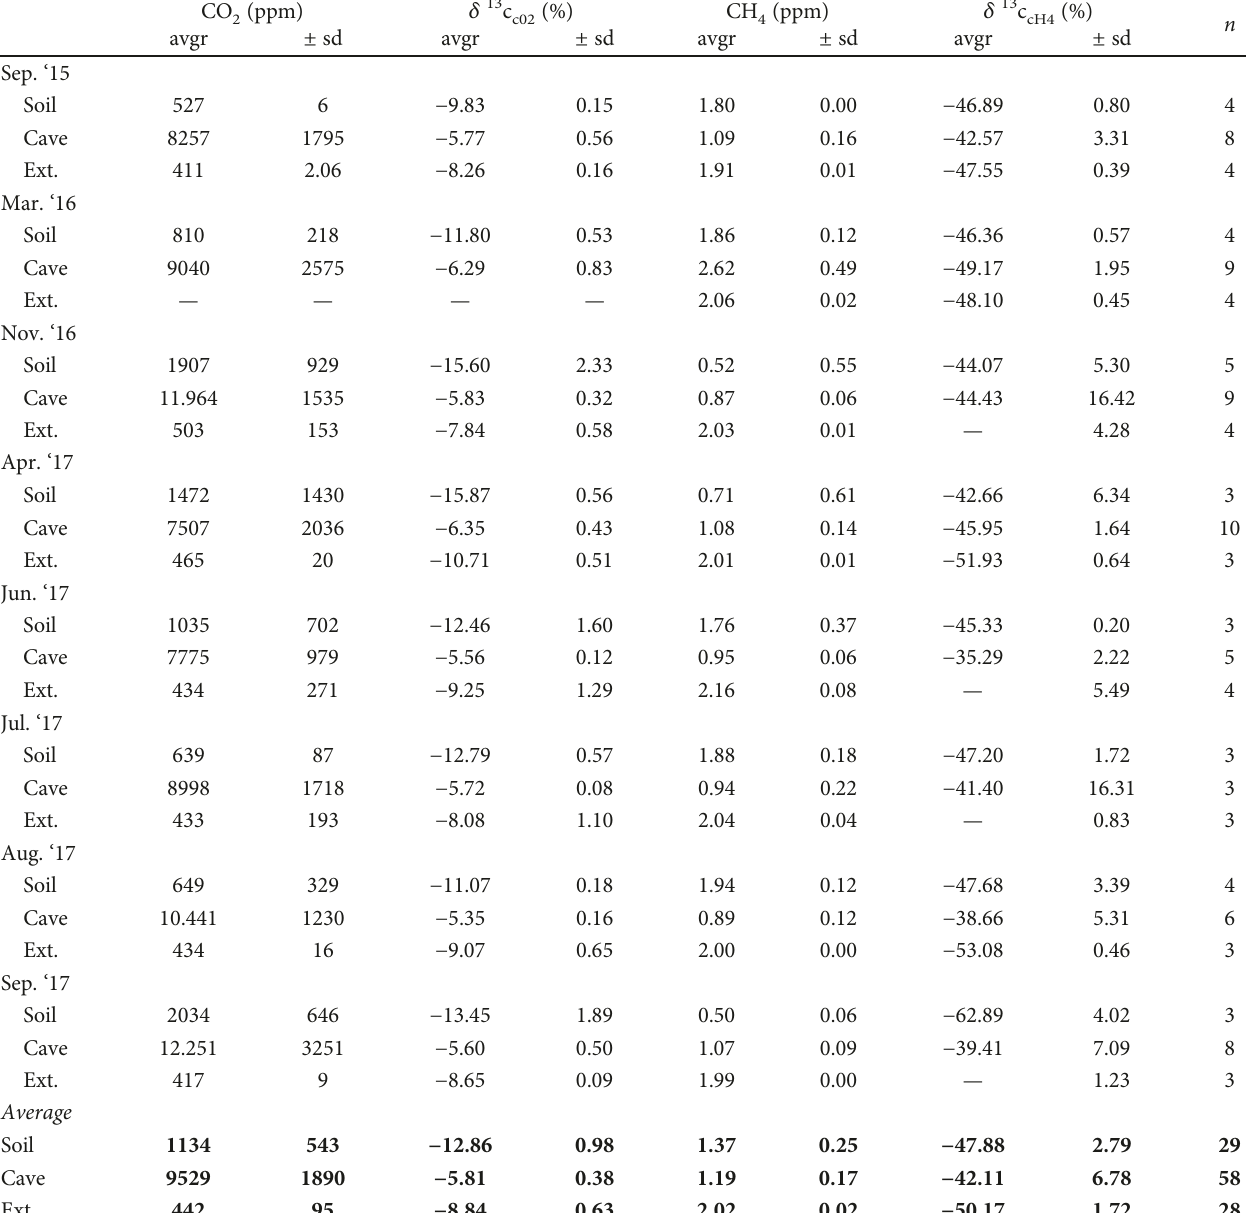
Table 2: Mean measurements (and ± sd: standard deviation) for the concentrations of CO ( δ 13 C and δ 13 C ) in the cave environment, and in vertically adjacent soils and the local outdoor atmosphere. CO2 CH4 CO 2